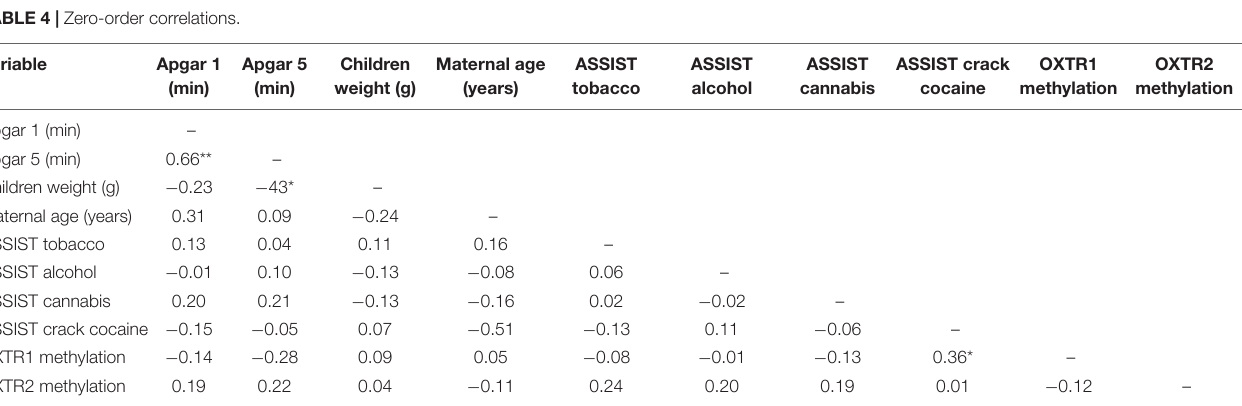
PCE, prenatal cocaine-exposed newborns; NEC, non-exposed to cocaine newborns; OXTR1 met, OXTR1 methylation; OXTR2 met, OXTR2 methylation; CpG, cytosine- phosphate-guanine. Data are presented as mean and standard deviation. Effect size refers to Cohen’s d. TABLE 4 | Zero-order